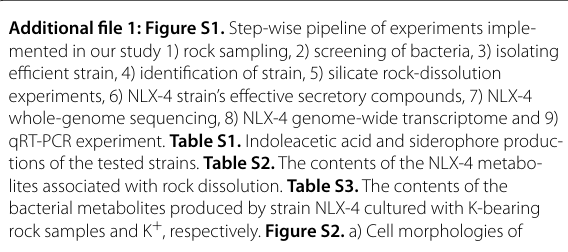
Figure S11. The results of randomness assessment showing the distribu- tion of reads mapped to the reference genome. Figure S12. Distribution of gene’s coverage for individual sequenced samples. Figure S13. Cor- relation analyses of three biological replicates in treatment and CK groups, respectively. The Pearson correction coefficients are shown in the upper right corner of the plot. Figure S14. Detailed workflow implemented for the illumina RNA-Sequencing and the sequencing analysis pipeline for obtaining for the gene annotations. Figure S15. The enriched and significant KEGG pathways based on their differentially expressed genes and the total number of genes belonging to each pathway. Figure S17. The qRT-PCR analysis of the specifically selected six differentially expressed genes involved in the rock-dissolution process, selected based on the RNA-Seq results. Figure S18. The differentially expressed genes (DEGs) obtained from transcriptome analysis. a) fold change results b) DEGs both up and down-regulated c) volcano plot. Figure S19. a) Total number of novel transcripts discovered based on the transcriptome data analysis, which includes both novel transcripts in coding and non-coding regions; b) Total number of differentially expressed sRNA in control and treatment samples; c) distribution of the total number of sRNA’s and their length; d) Top differentially expressed sRNA’s represented by its candidate-ID